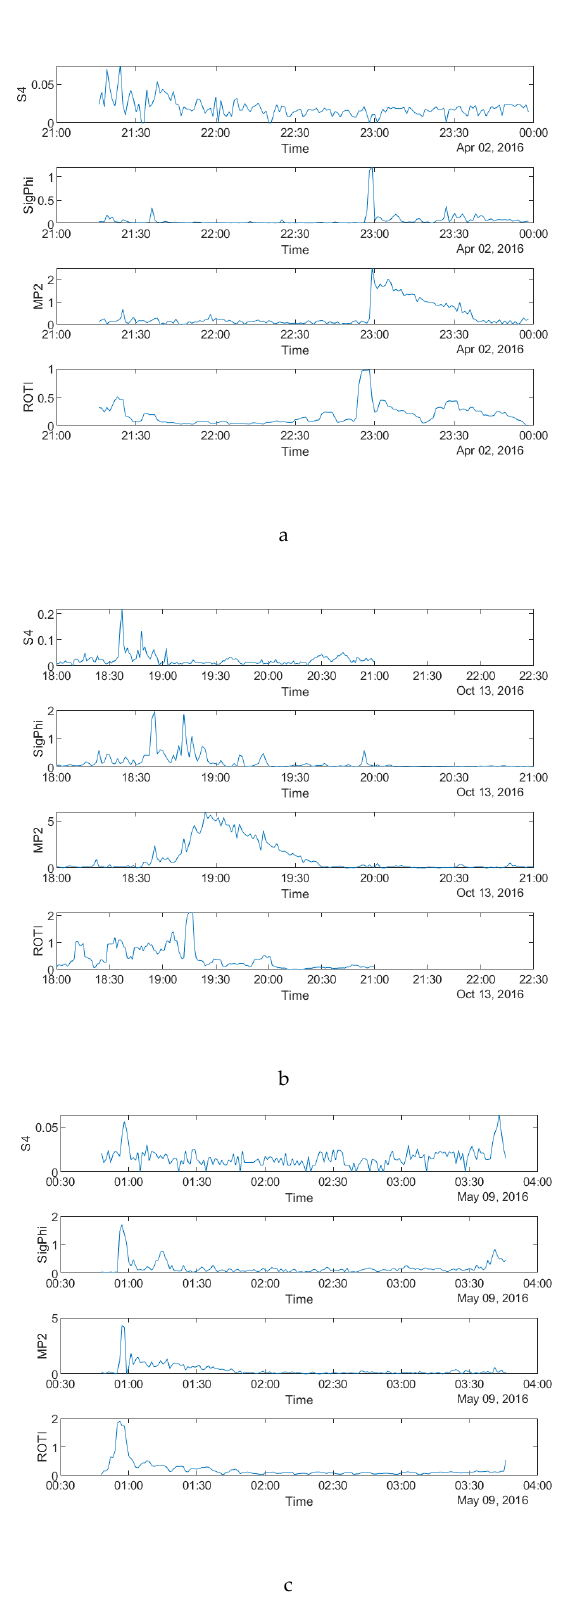
Figure 12. Time series plots of four parameters at SNA0P station on: ( a ) during 18:00:00–24:00:00 UTC on 2 April 2016 for PRN03; ( b ) during 18:00:00–24:00:00 UTC on 13 October 2016 for PRN17; ( c ) during 00:00:00–06:00:00 UTC on 9 May 2016 for